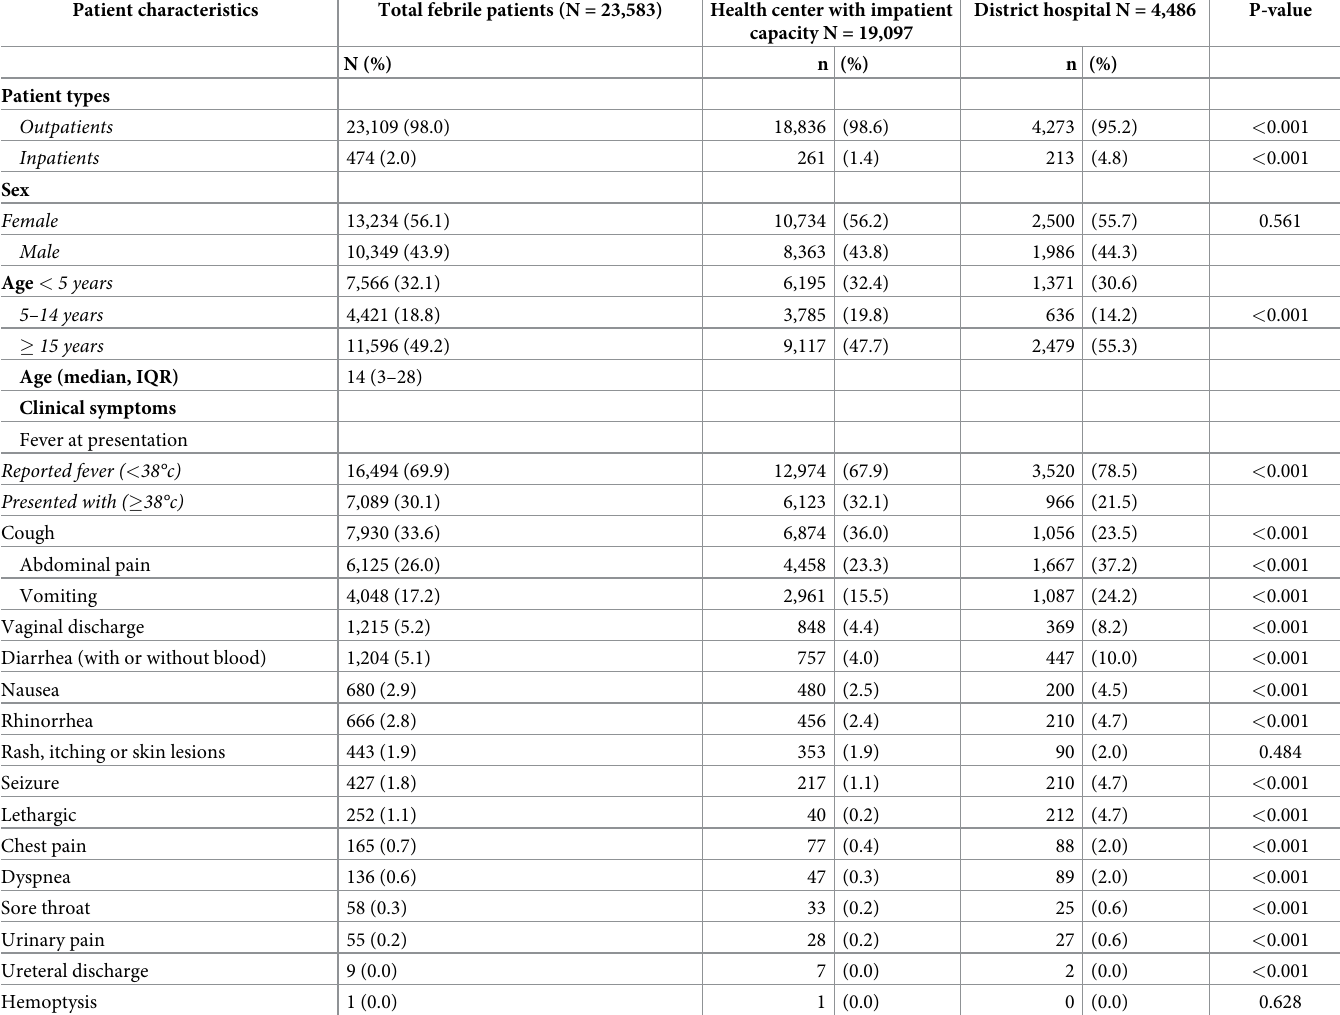
Table 1. Sociodemographic characteristics and clinical symptoms of febrile patients (N = 23,583) presenting at the two selected facilities in the rural health district of Fore´cariah, Guinea, 2014–2020. Patient